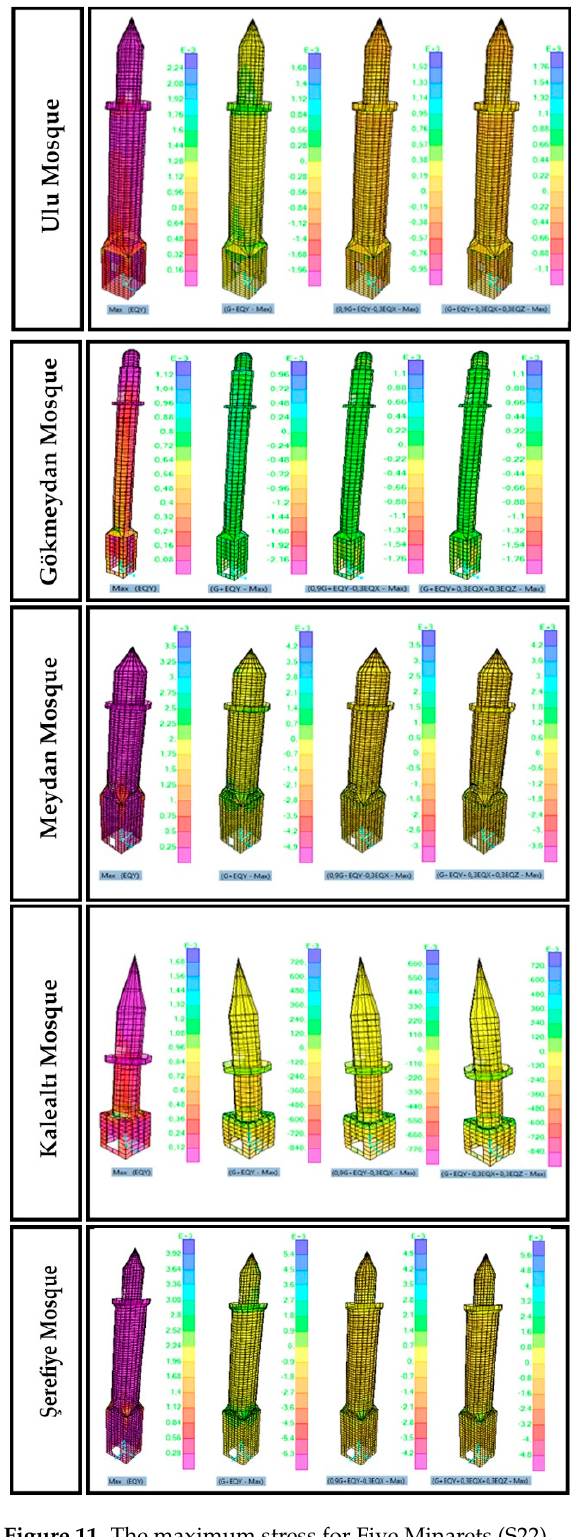
Figure 11. The maximum stress for Five Minarets (S22). The diagrams of shear stress in the x-y directions (S12) for five minarets under different load combinations are shown in Figure 12.